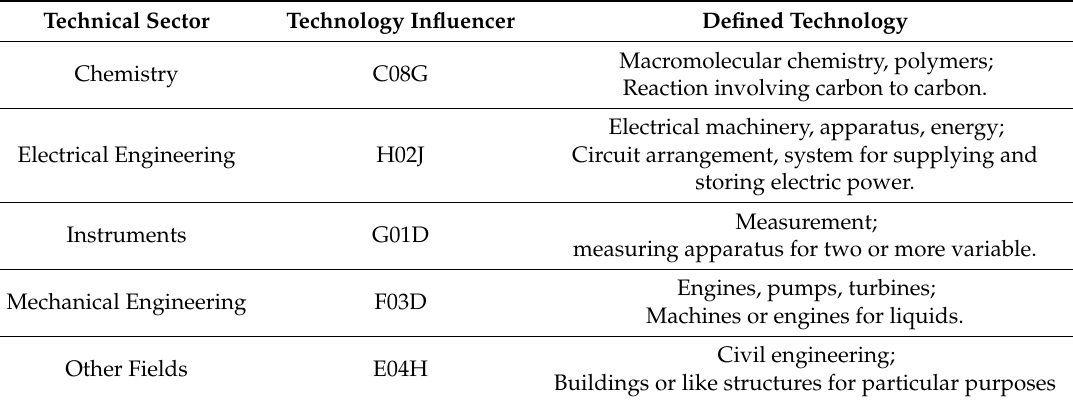
Table 10. Technology